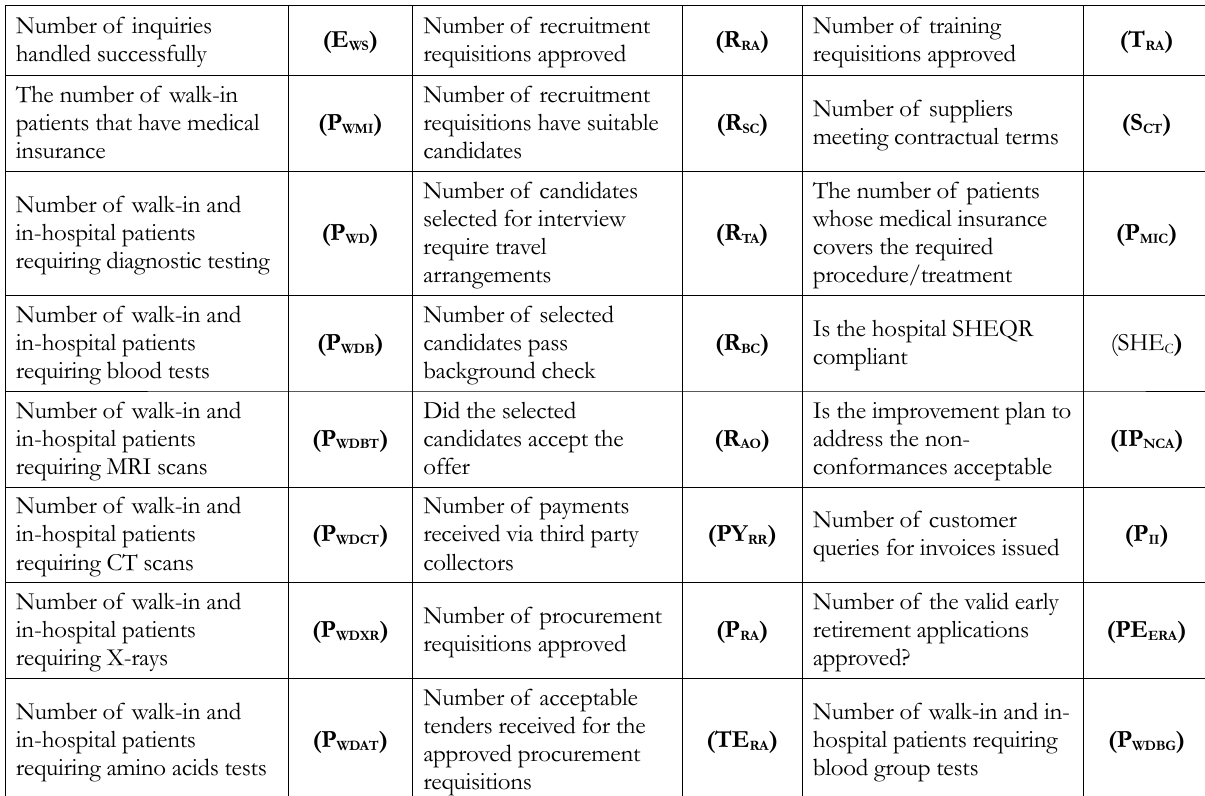
Table 2. Sample of variables influencing hospital